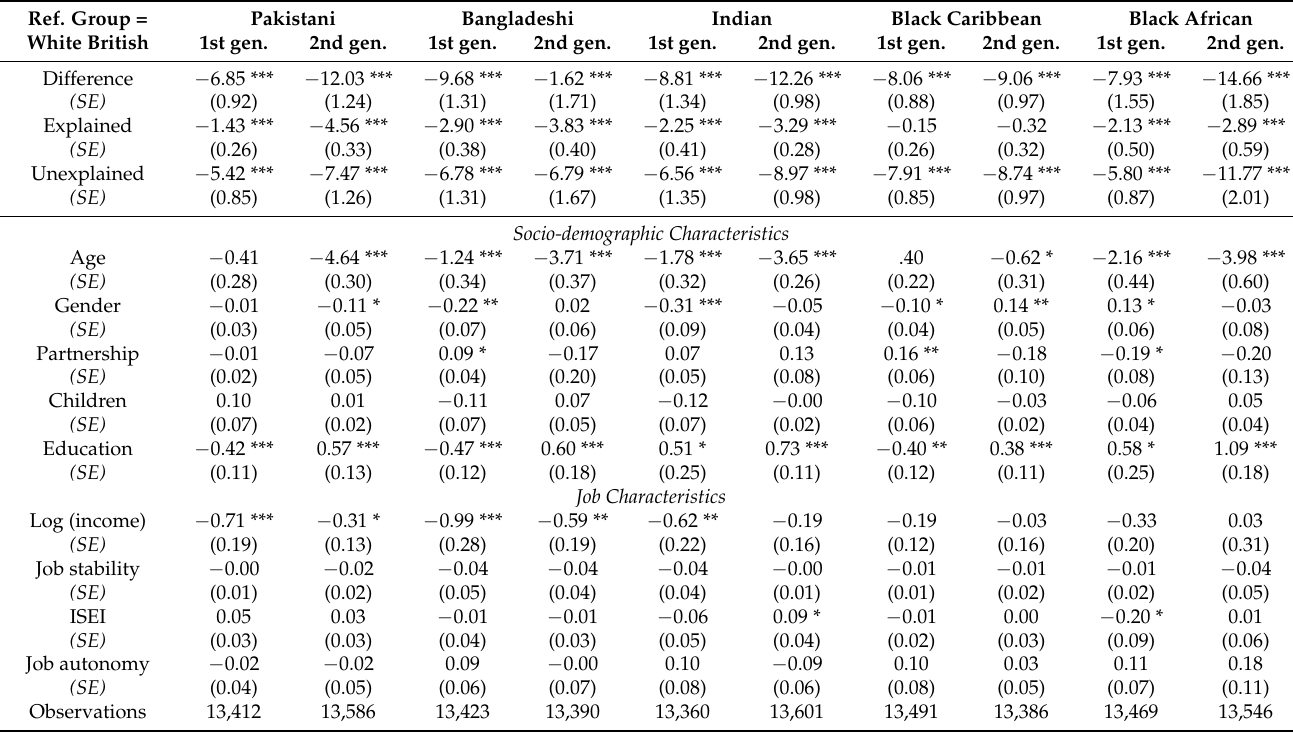
Table 2. Blinder-Oaxaca Decomposition Models of Extrinsic Work